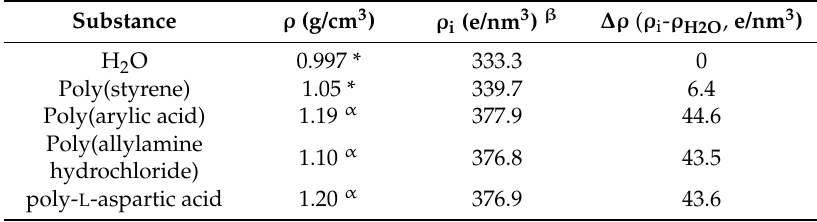
Table 1. Electron density of related